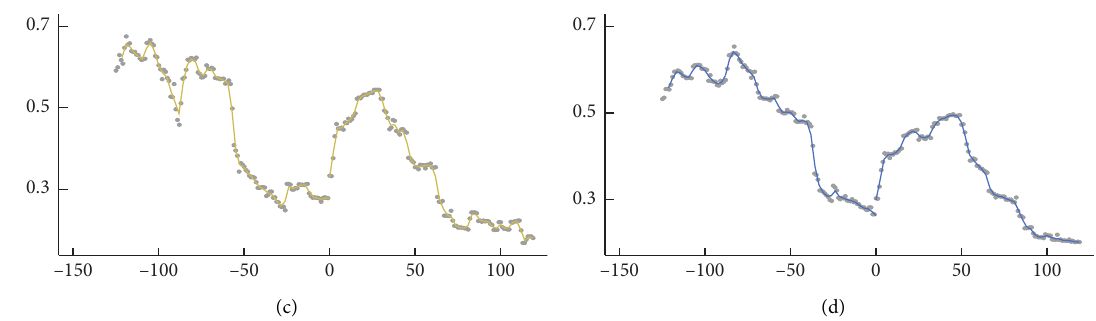
Figure 6: The RDD results of the energy industry. (a) hv5, (b) hv15, (c) hv30, and (d) hv50.